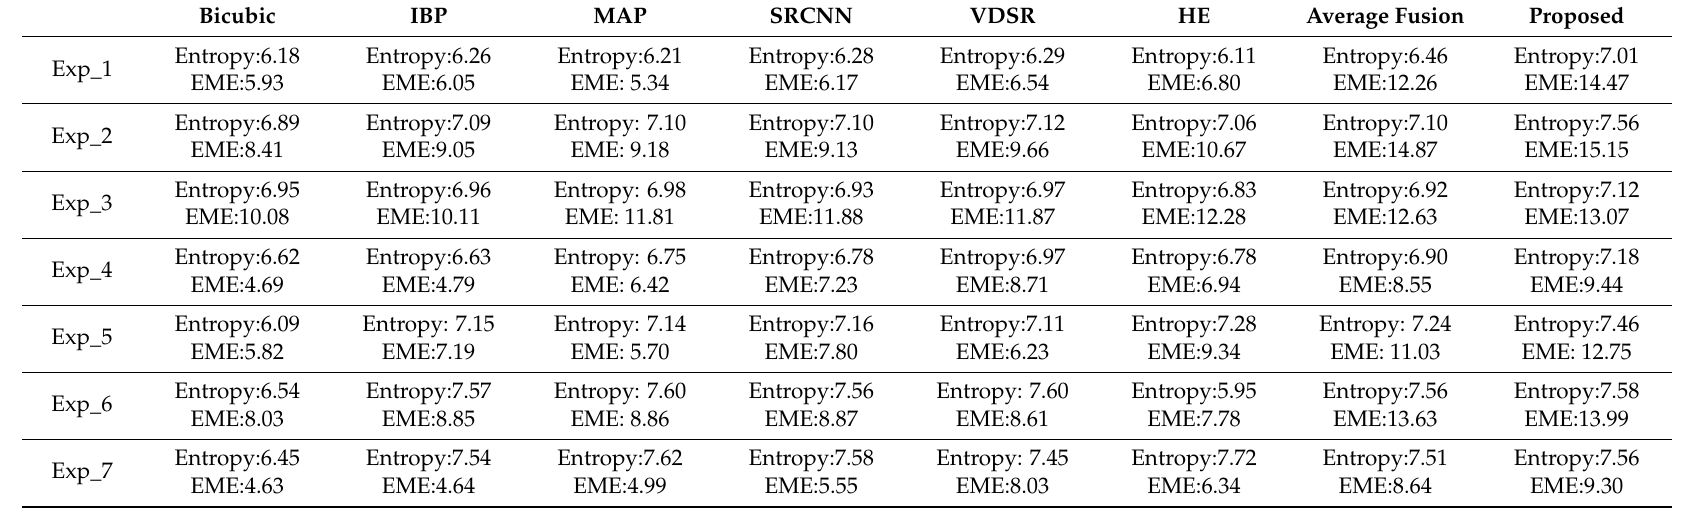
Table 3. Entropy and EME Values of Different Reconstruction Methods in Real Experiments. Bicubic IBP MAP SRCNN VDSR HE Average Fusion